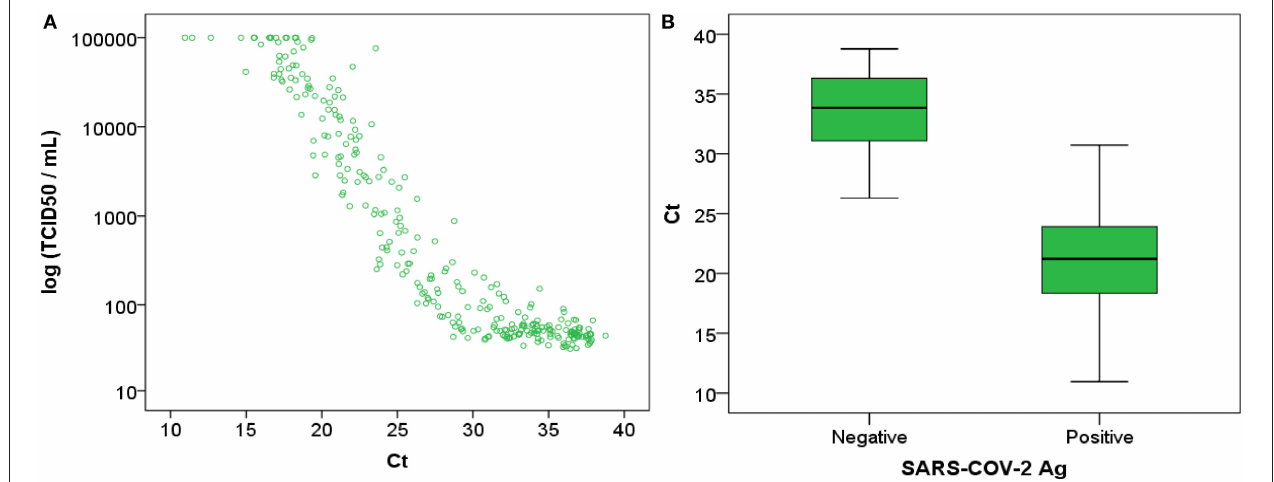
FIGURE 2 | (A) Ag TCID 50 /ml represented against RT-PCR Ct and ( B) RT-PCR Ct represented against antigen negative ( < 200 TCID 50 /ml) and positive ( > 200 TCID 50 /ml) results. Ct, cycle threshold; Ag, antigen; TCID, Tissue Culture Infectious Dose per milliliter.